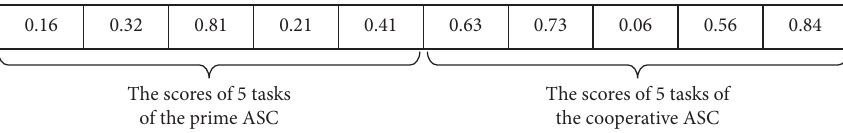
Figure 4: An individual representation of five tasks for the twin